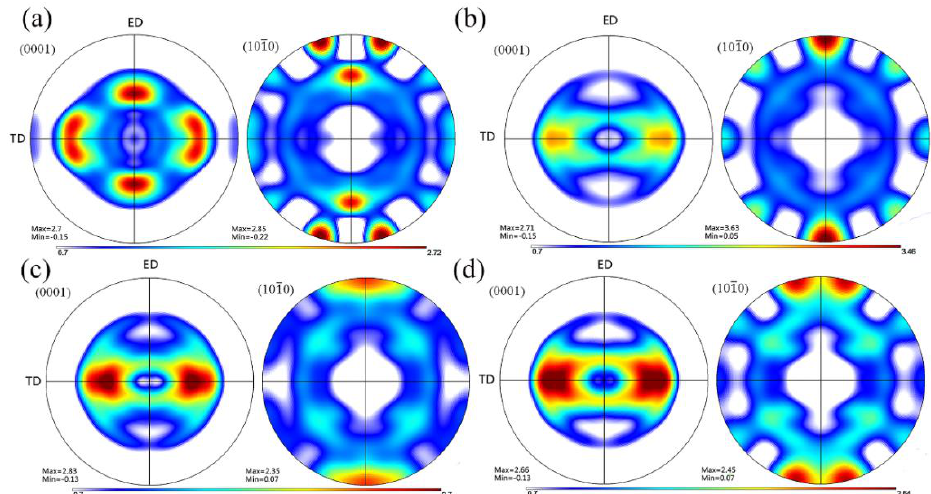
Figure 6. Textures of the four-pass extruded alloys: ( a ) Mg-2Zn-0.5Zr alloy [13]; ( b ) Mg-2Zn-0.5Gd- 0.5Zr alloy [13]; ( c ) Mg-2Zn-0.5Nd-0.5Zr alloy; and ( d ) Mg-2Zn-0.5Y-0.5Zr alloy.